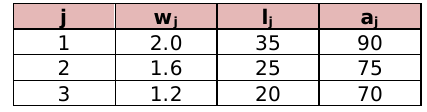
Table 1. “Characteristics of the